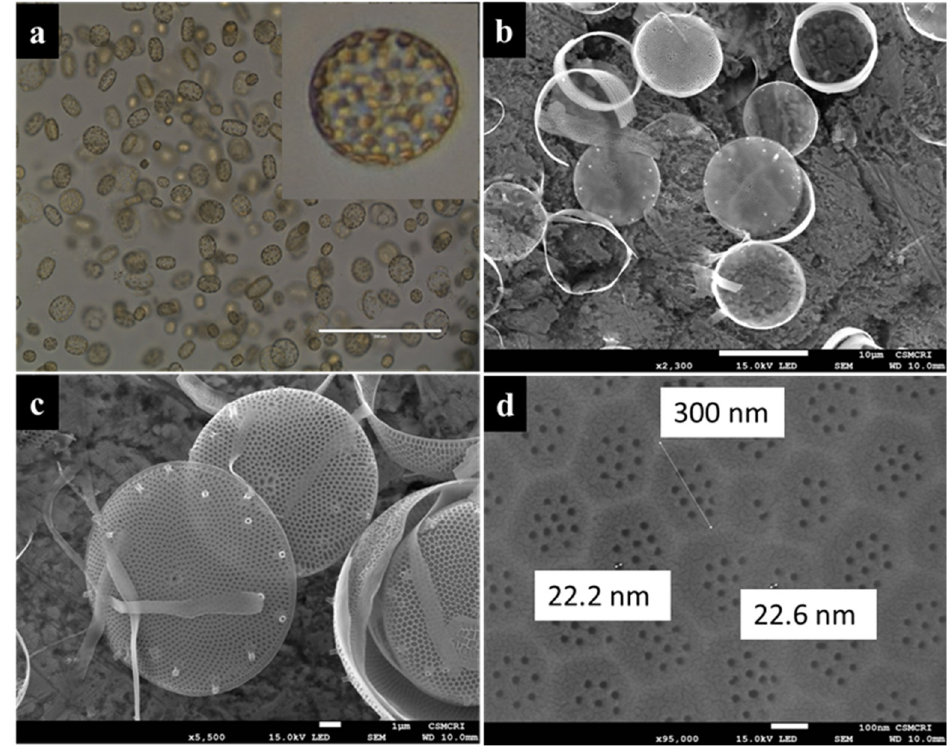
Figure 2. Microscopic images of diatom T. lundiana CSIRCSMCRI 001 ( a ). Unialgal culture live photos under light microscopy at 40× and 100×; ( b , c ) acid cleaned diatoms cells; ( d ) silica frustules surface appears as hexagonal sculpts with 8–10 pores in 20–22 nm diameter (scale 100 nm).